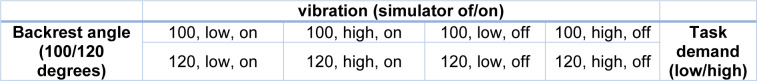
The matrix of three independent variables to make eight active tests